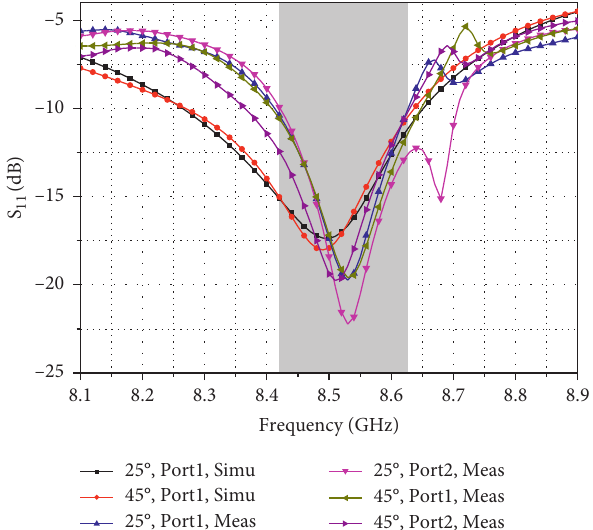
Figure 18: The S 11 measured result of different beam steering direction of the RPA prototype.